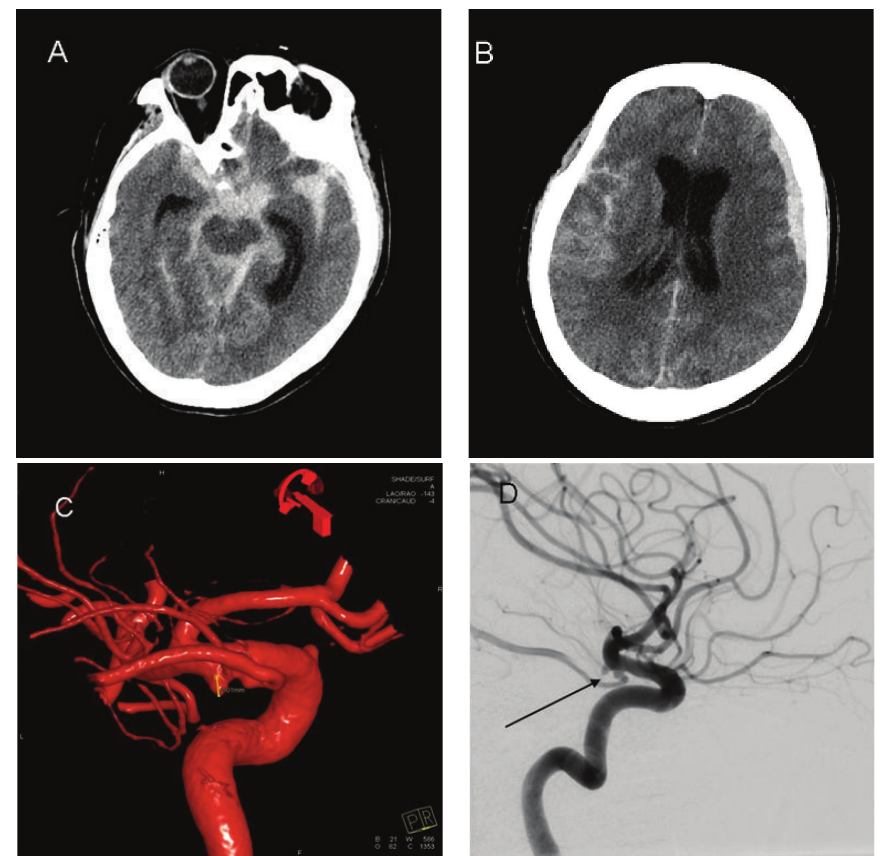
Figure 1: Admission CT and DSA. CT = computed tomography and DSA = digital subtraction angiogram. (A) Axial uninfused CT of the brain at the level of the mesencephalon displaying thick subarachnoid clot in the basal cisterns. (B) Axial uninfused CT of the brain at the level of the lateral ventricles displaying hydrocephalus, a small left acute subdural hematoma and diffuse SAH. (C) Lateral projection of left internal carotid artery injection via DSA displaying a small anterior choroidal artery aneurysm (black arrow). (D) Three-dimensional reconstruction of DSA displaying anterior choroidal artery aneurysm on the inferior portion of the supraclinoid internal carotid